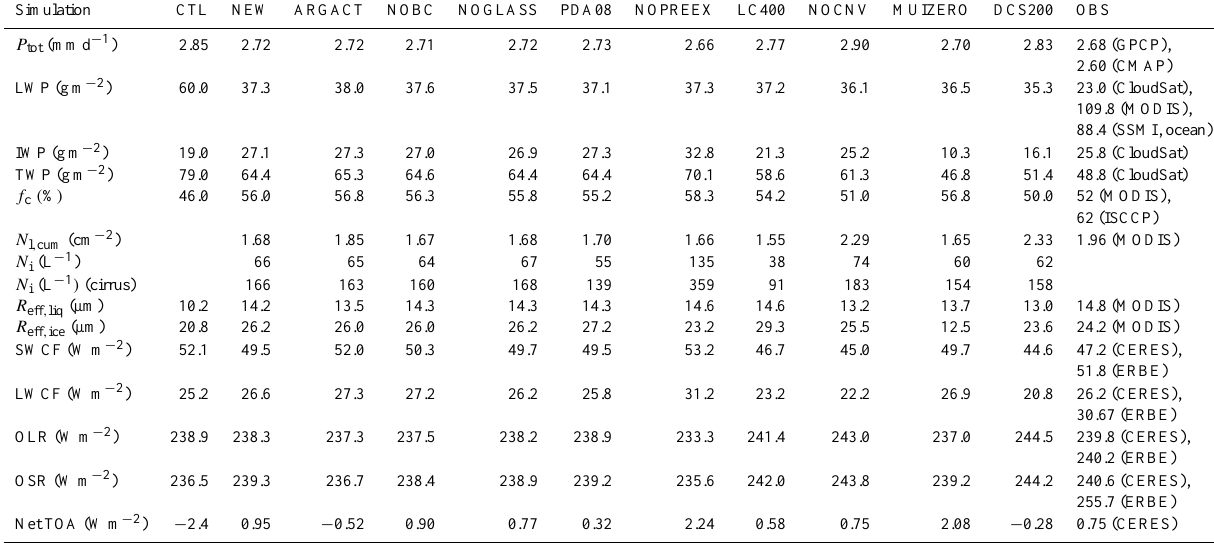
Table 4. Annual mean model results and observations. The experimental data sets are described in Sect. 3. CTL and NEW refer to runs with the operational version of GEOS-5 and with the implementation of the new microphysics, respectively. Sensitivity studies are described in Table 3 and Sect.